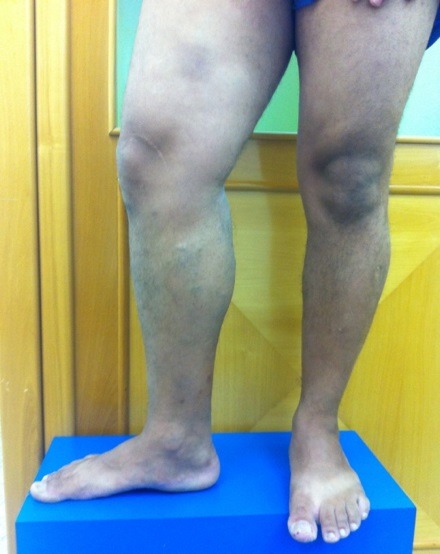
Lower limbs with patient standing upright, front view, showing asymmetry of right lower limb.